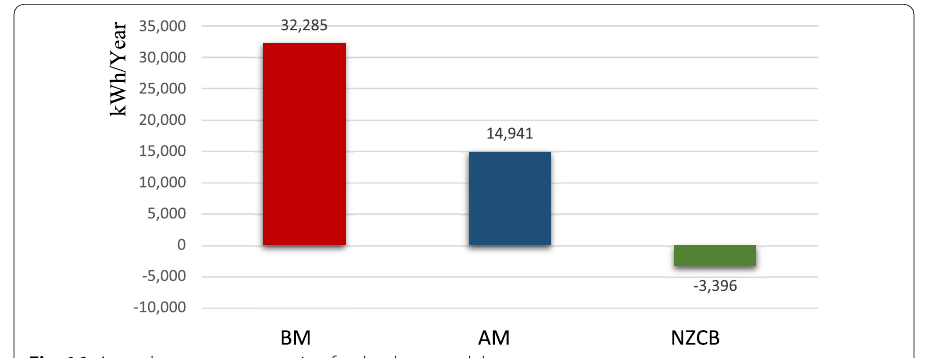
Fig. 16 Annual energy consumption for the three models